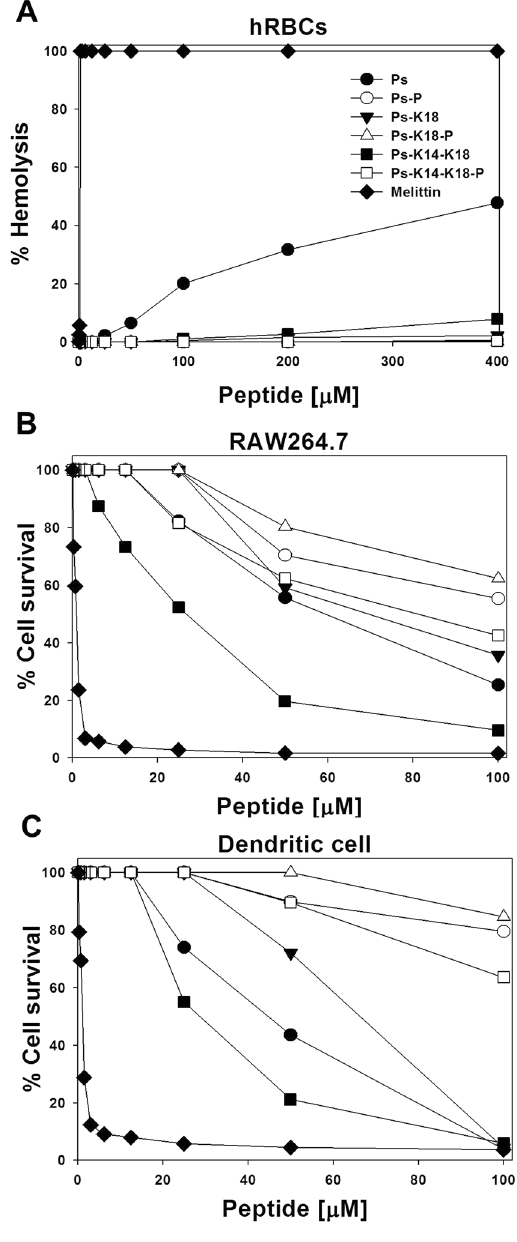
Figure 2. Concentration-dependent toxic activities of Ps and its analogues toward ( A ) human RBCs, ( B ) mouse macrophage-derived RAW264.7 cells and ( C ) mouse bone marrow-derived dendritic